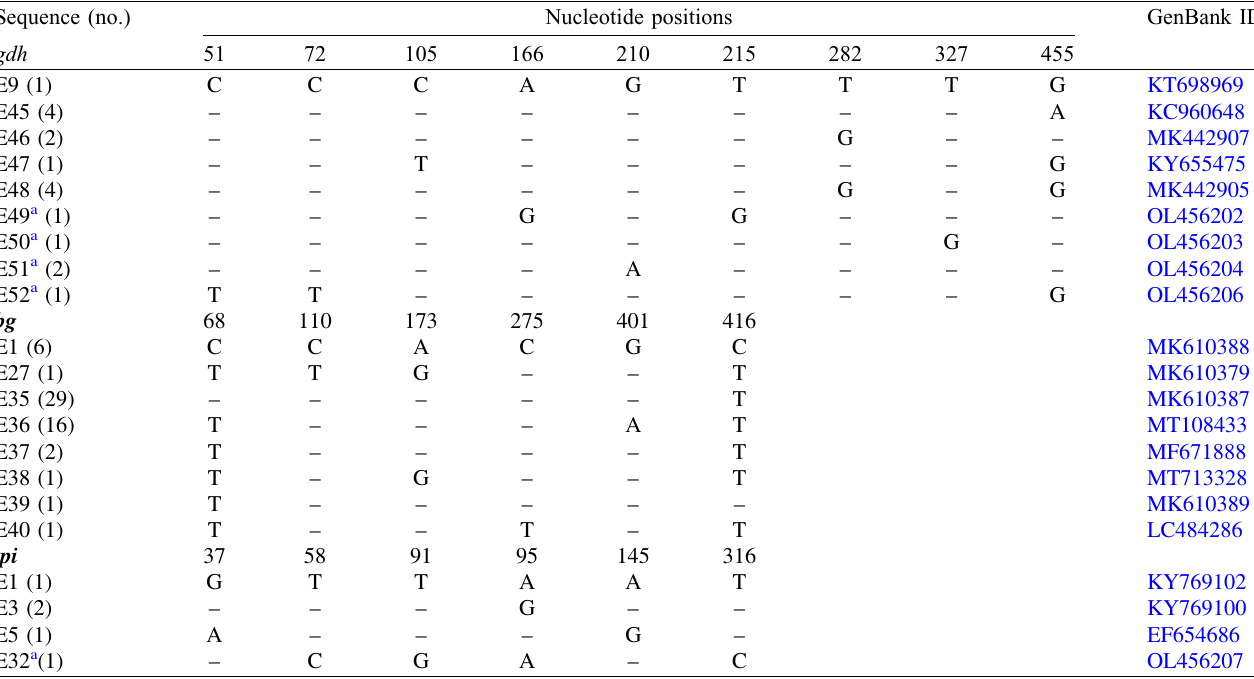
Table 3. Intra-assemblage substitutions in bg , gdh , and tpi sequences within G. duodenalis assemblage E. Sequence